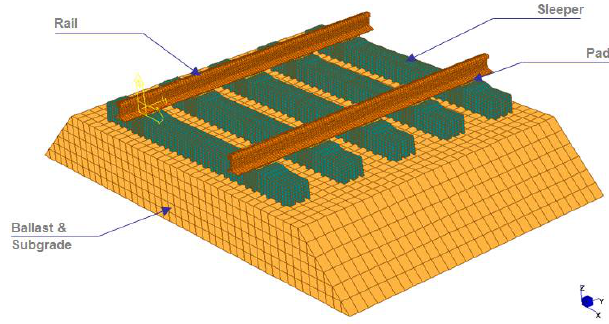
Figure 1. Components of railway tracks.